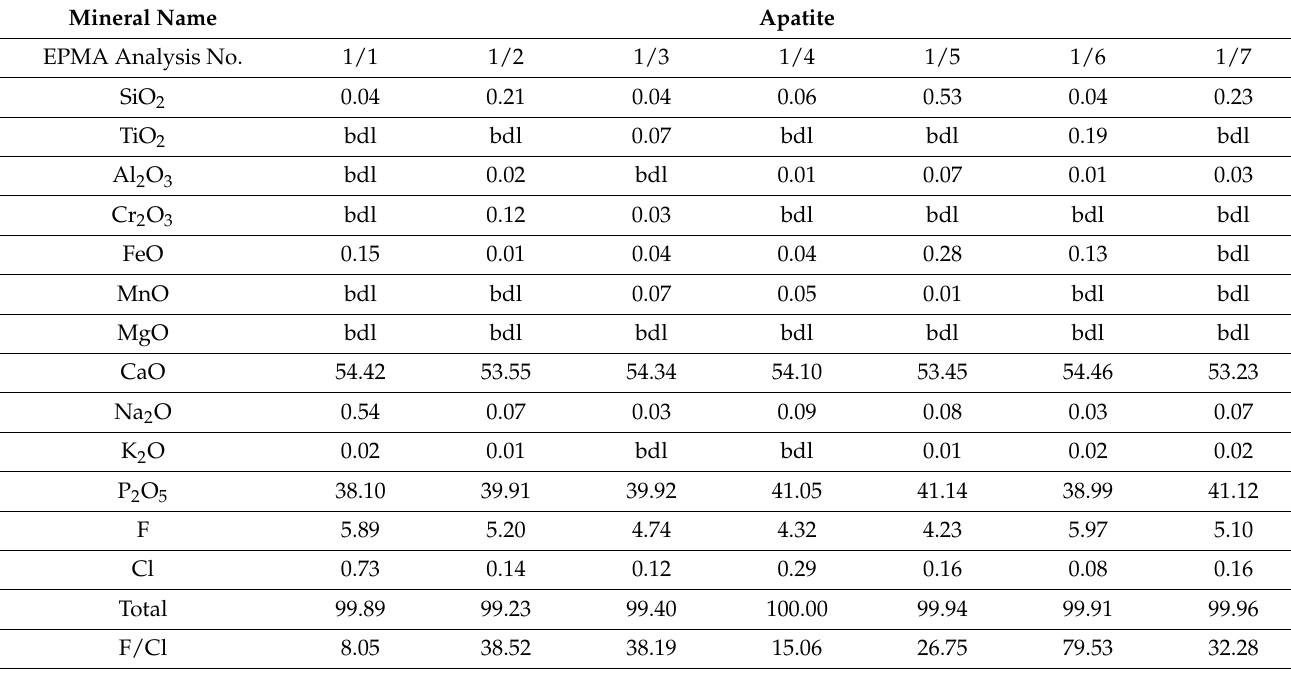
Table 3. EPMA data of apatite (in Wt%) from the Jagpura gold-copper deposit, western India. Lithology: Quartz-mica schist, Sample No.